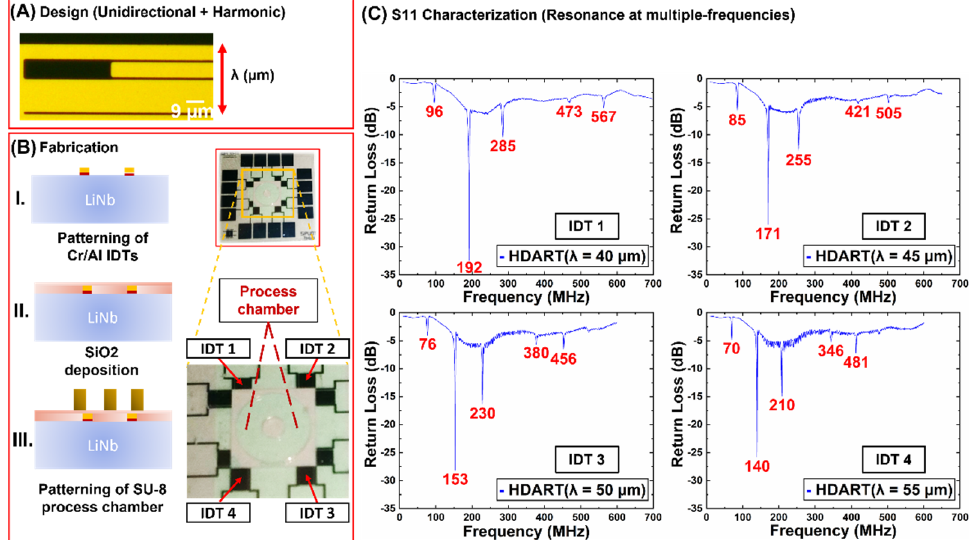
Figure 2. Figure depicting design, fabrication and the S11 characterization of the Distributive Array Unidirectional Transducers demonstrating harmonics (dubbed as HDART). ( A ) Top view of one set of interdigitated electrodes. Lambda ( λ ) indicates the wavelength. ( B ) Fabrication procedure of the Haemoprocessor system including the electrodes and the chamber. The HDARTs were designed and fabricated such that the wavelengths of 40, 45, 50, and 55 µm could be actuated on one device. (Note that another set of IDTs, at 90° to the first set, is also present, albeit not used in the following experiments.) ( C ) S11 characterization data of the HDARTs. Note the overtones expressed in each IDT type: the 1st and 2nd overtones were quite strong.